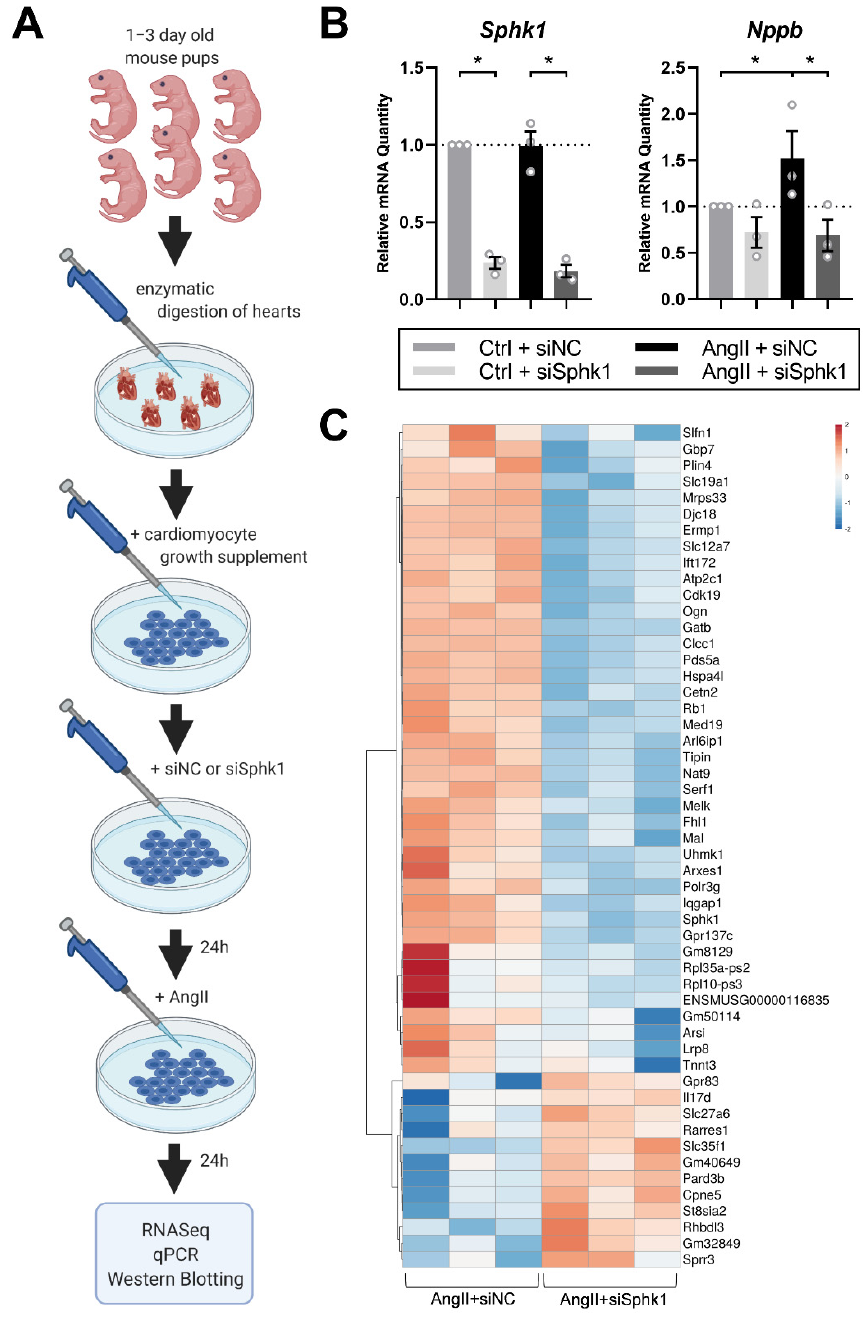
Figure 1. Sphingosine kinase 1 ( Sphk1 ) silencing affects the transcriptome of angiotensin II (AngII)- treated neonatal cardiomyocytes (CMs). ( A ) Schematic representation of the experimental design (created with BioRender.com). ( B ) Expression of sphingosine kinase-1 ( Sphk1 ) and natriuretic peptide type B ( Nppb ) quantified using real-time polymerase chain reaction in neonatal CMs transfected with siNC or siSphk1 and treated with 1 µ M AngII or a control buffer (Ctrl) for 24 h. Each point corresponds to an independent experiment (biological replicates, each performed in quadruplicate). Data are represented as means ± SEM, * p < 0.05; ( C ) All 52 genes for which mRNA expression was >2.5 times up- or downregulated (FDR p < 0.05) by siSphk1 treatment in neonatal CMs. The heatmap, created with Clustvis [19], shows the results from three independent sets of experi- ments.